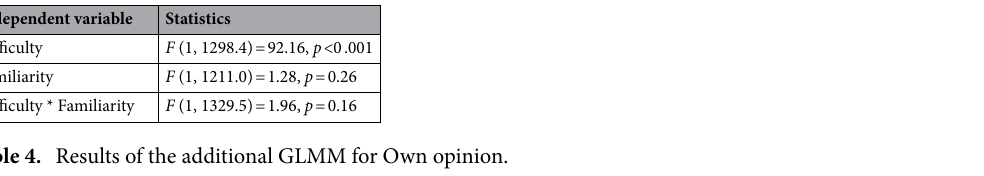
Table 4. Results of the additional GLMM for Own opinion.